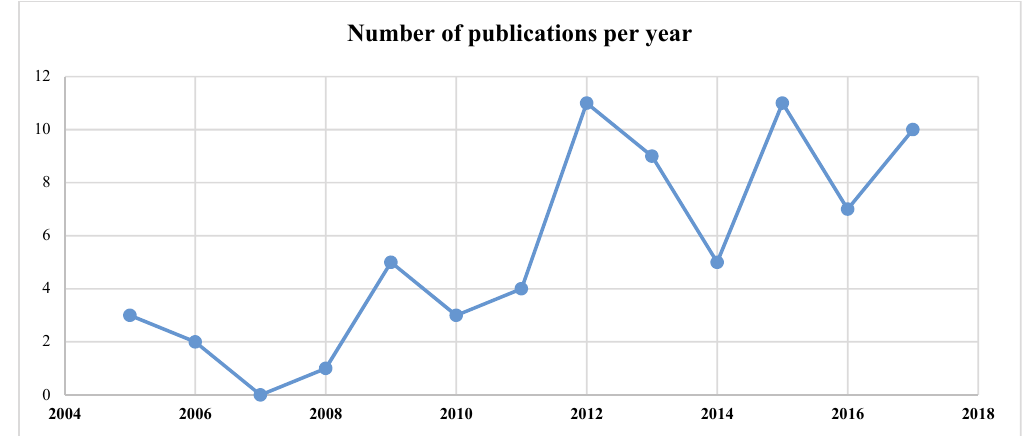
Fig. 3. Distribution of publications regarding